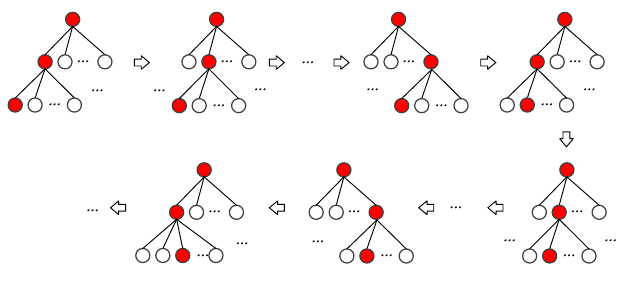
Figure 4. Reverse-lexicographic